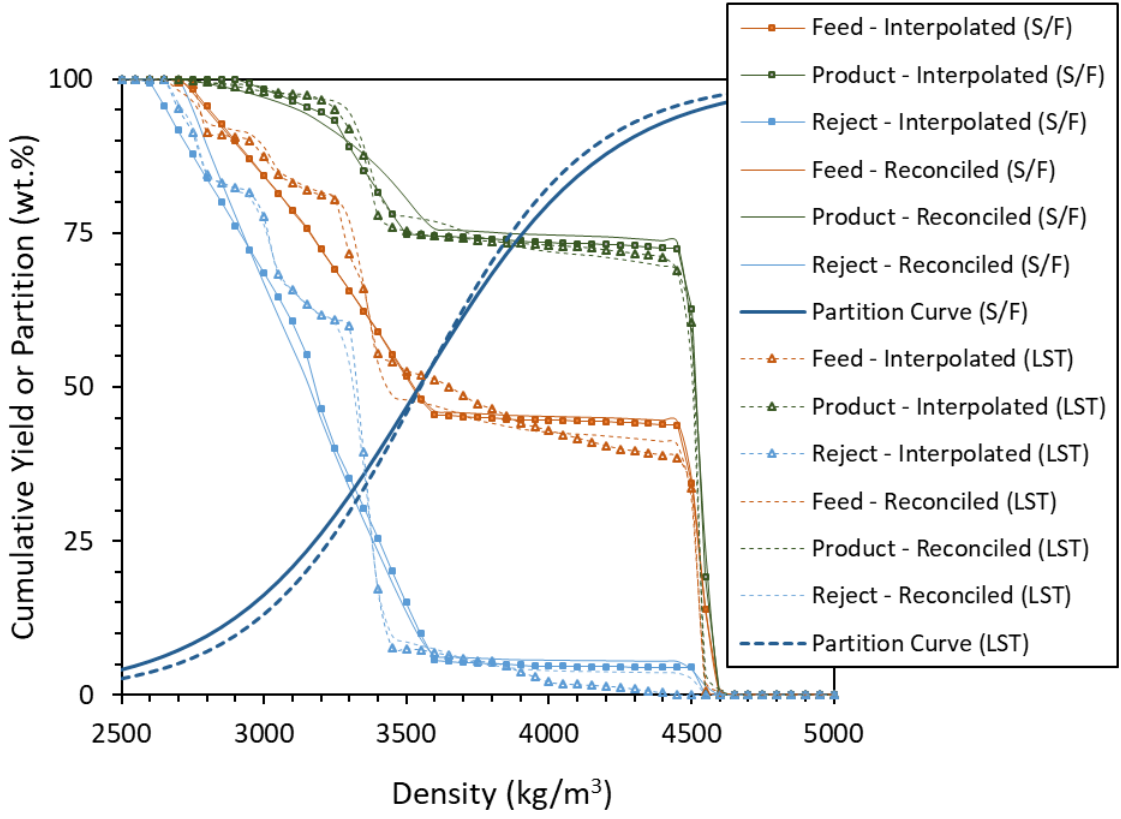
Figure 4. Cumulative yield as a function of incremental density for the – 300 + 106 µm portion of the feed, product and reject. The algorithm was applied to the sink/float (S/F) and LST flow fractionation (LST) interpolated datasets to generate reconciled cumulative yield versus density datasets for each stream which are linked by underlying partition curves. The sink/float partition curve is described by D 50 = 3544 kg/m 3 and Ep = 364 kg/m 3 , while the LST partition curve is governed by D 50 = 3550 kg/m 3 and Ep = 318 kg/m 3 . The partition curves produced by the two methods are in excellent agreement. RC separation z = 3 mm; RC flow fractionation z = 1.77 mm.